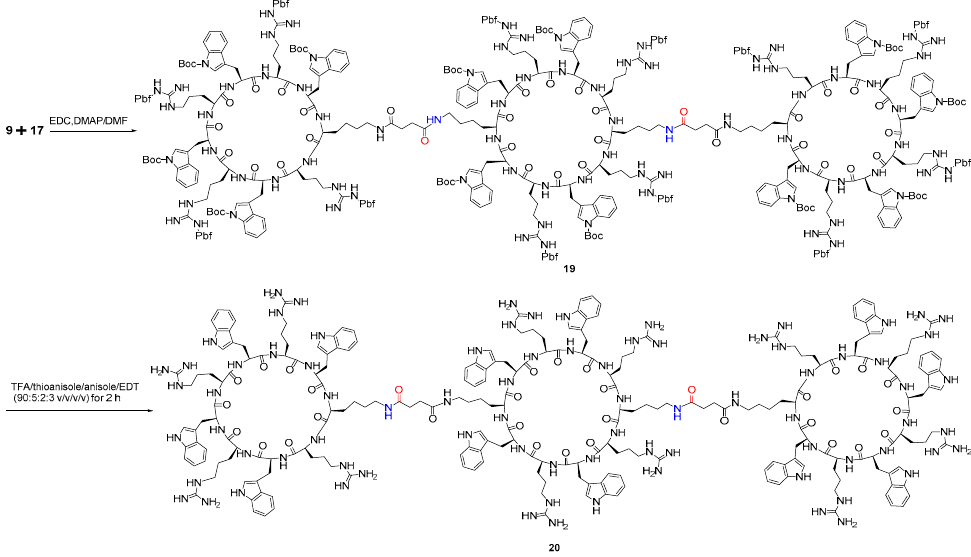
Scheme 3. Synthesis of cyclic peptides containing one free amino group ( 16 ) and one free carboxylic acid ( 17 and 18 ).